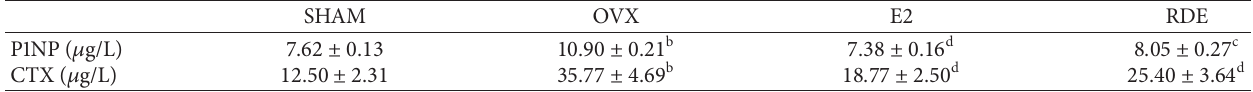
Table 3: Effect of RDE on PINP and CTX in serum after 12 weeks of treatment. SHAM